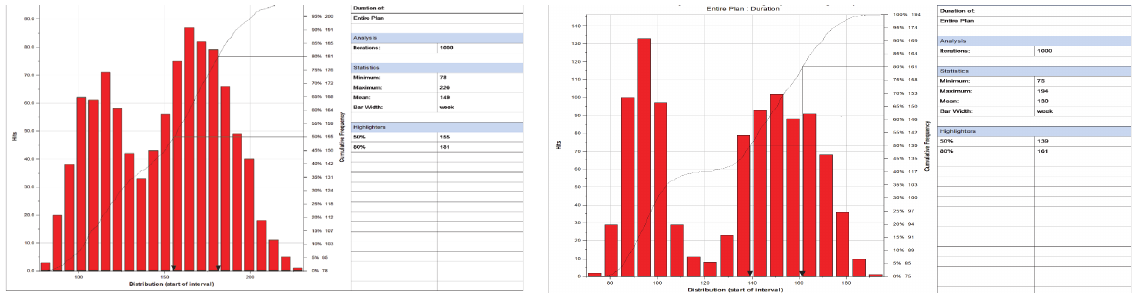
Fig. 5. Pre-mitigation Finish Duration Histogram Fig. 6. Post-mitigation Finish Duration